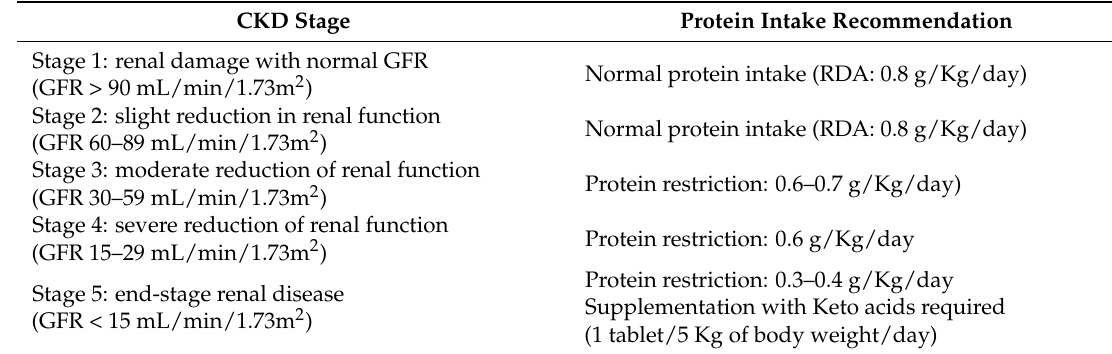
Table 1. Dietary protein recommendations for CKD patients stage 1–5 not on dialysis (adapted from